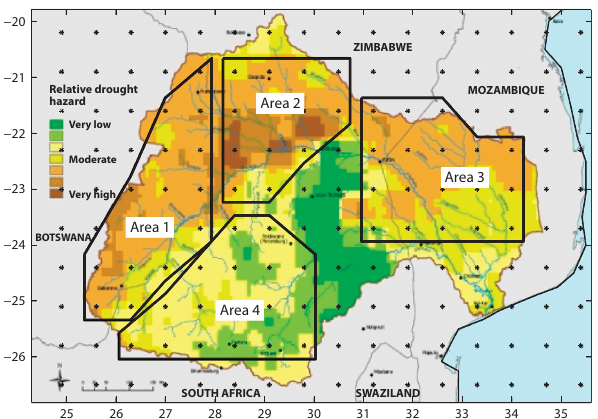
Figure 2. Areas of drought hazard for the Limpopo basin. The four areas are characterised by their sensitivity to droughts, ranging from low/moderate to very high/high. The underlying maps are from Muñoz Leira et al. (2003). The grid points denote the grid points of the ECMWF seasonal forecasting system (SYS4) on a T319 re- duced Gaussian